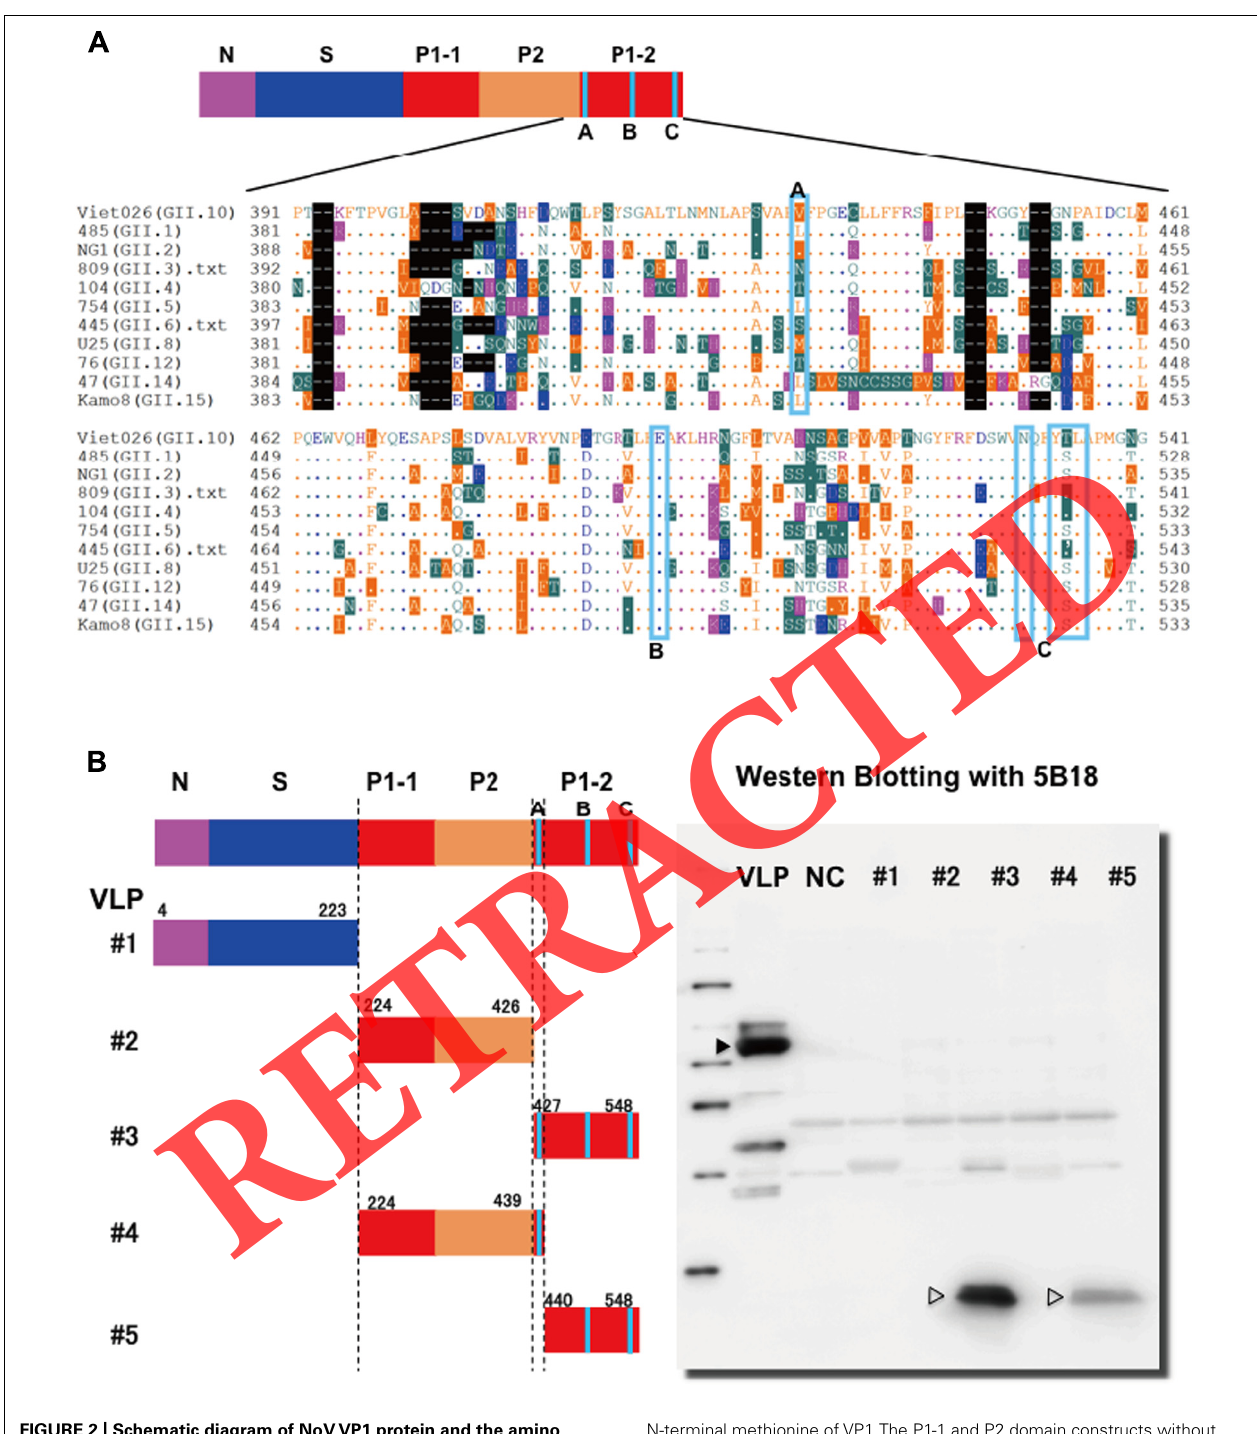
N-terminal methionine ofVP1.The P1-1 and P2 domain constructs without binding site A are construct 2 (amino acids 224–426), with binding site A is construct 4 (amino acids 224–439). Construct 3 has all binding sites A, B and C (amino acids 427–548). Construct 5 deletes binding site A from construct 3 (amino acids 440–548). Right panel of (B) : western blotting results with 5B-18. Samples indicated asVLP, NC (negative control), mutant construct 1 (#1), #2, #3, #4 and #5.The black arrow representsVLP band at 58 kDa, and the white arrows represent #3 and #5 products at 13